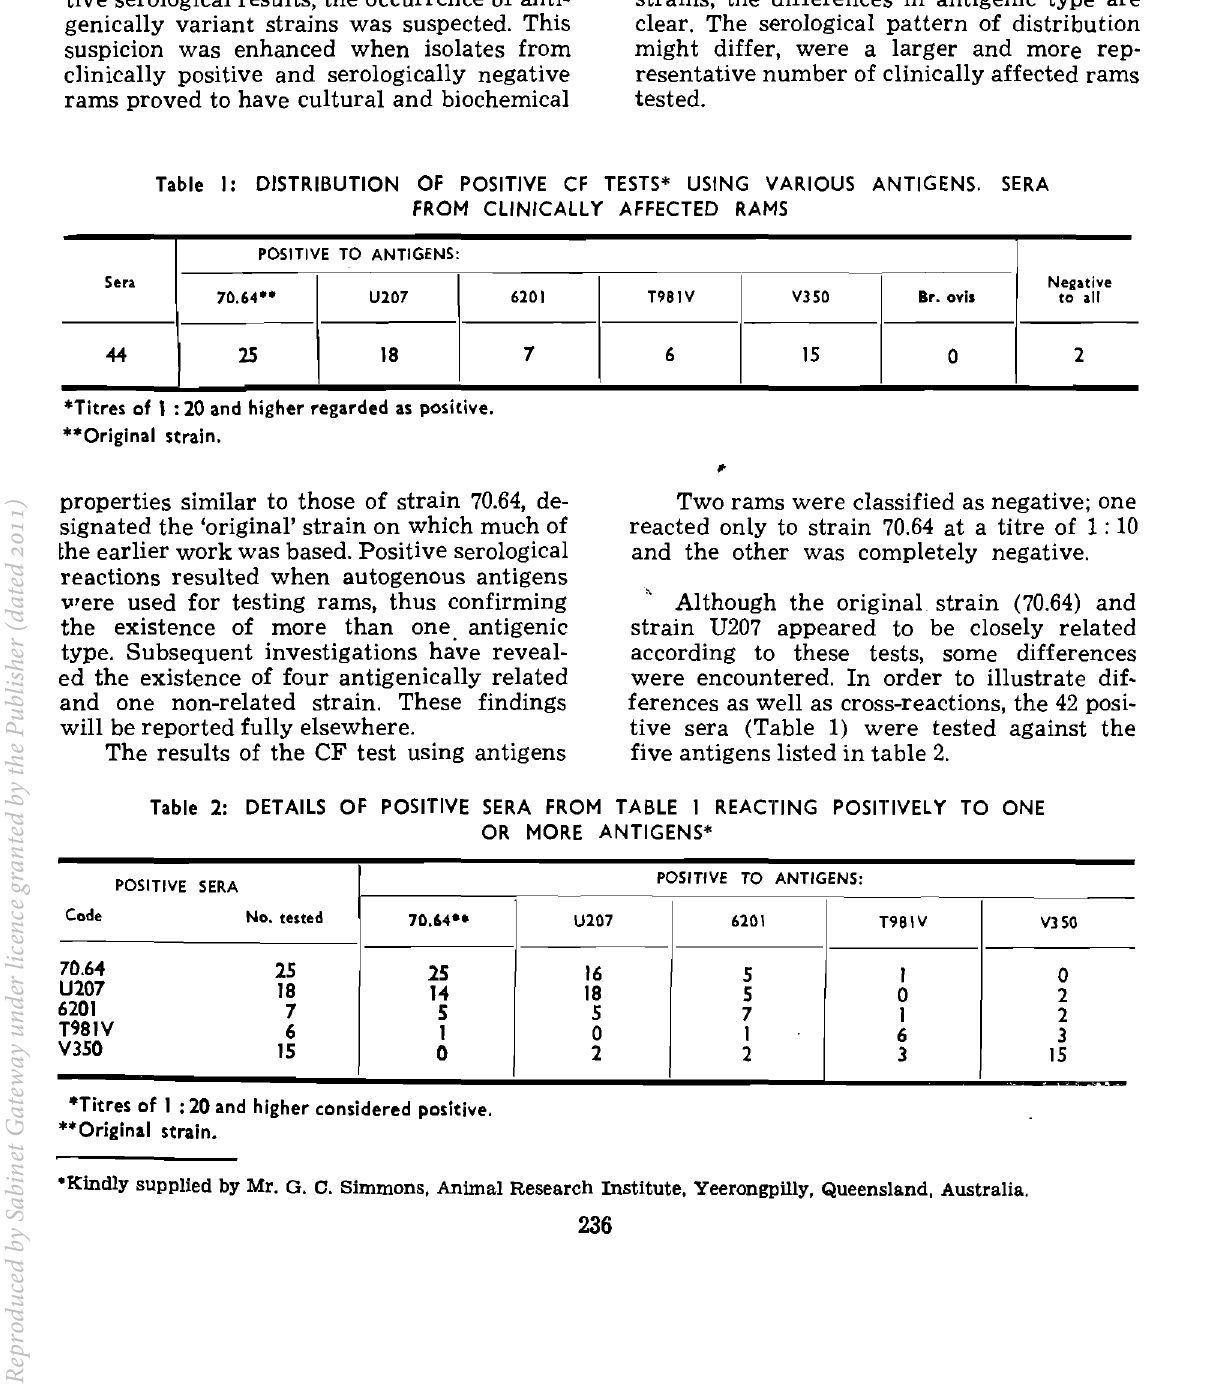
Table I: DISTRIBUTION OF POSITIVE CF TESTS* USING VARIOUS ANTIGENS. SERA FROM CLINICALLY AFFECTED RAMS